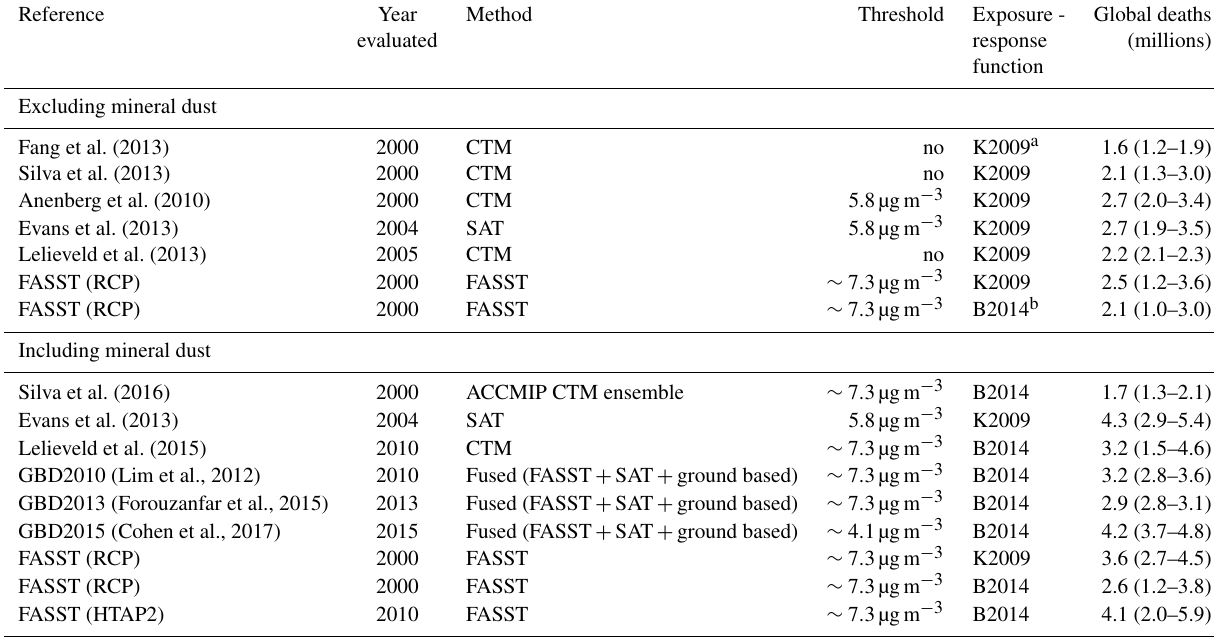
Table 14. Overview of previous studies on health impact of PM 2 . 5 , together with FASST results for two different scenarios. Uncertainty ranges are as reported in the respective studies. The uncertainty range on FASST results includes the RR uncertainty only (Fig. S5.1).